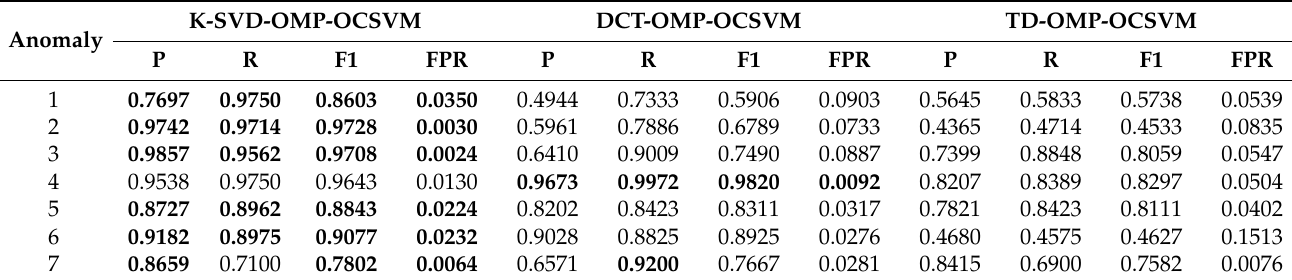
Table 4. Evaluation indicators of different dictionaries in SFAD.